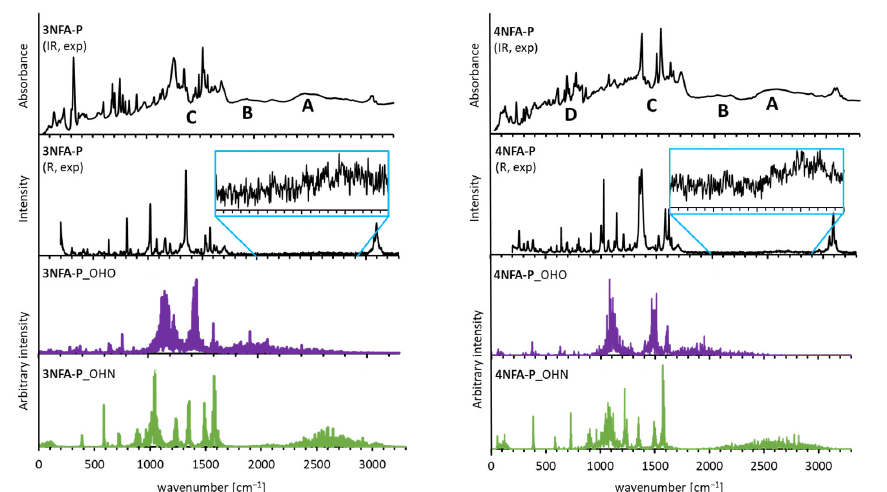
Figure 2. Experimental IR (IR, exp), Raman (R, exp) and atomic velocity power spectra ( 3NFA ‐ P _OHO/OHN and 4NFA ‐ P _OHO/OHN) for the hydrogen ‐ bonded protons of 3NFA ‐ P and 4NFA ‐ P complexes are presented on left and right panels, respectively. A , B , C and D denote the bands related to the strong hydrogen bond, discussed in the